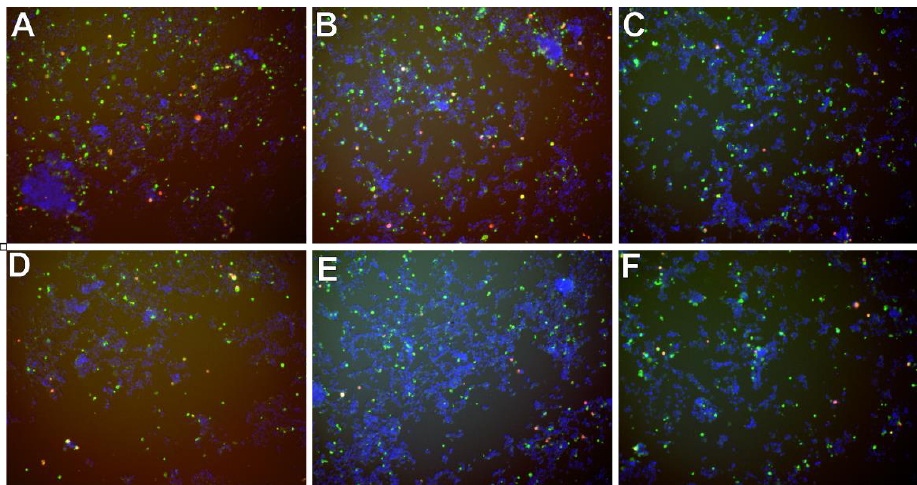
Figure 9. Exemplary micrographs of apoptosis evaluation after staining with Annexin-V conjugated with fluorescein (green color) and propidium iodide (red color), and all cells-after staining DAPI cell nuclei (blue color) at a concentration of 50 µM-for curcumin ( A , D ), trans-resveratrol ( B , E ) and wogonin ( C , F ). Photos A, B, C are taken in the chip’s CC. Photographs ( D – F ) in a multiwell plate.